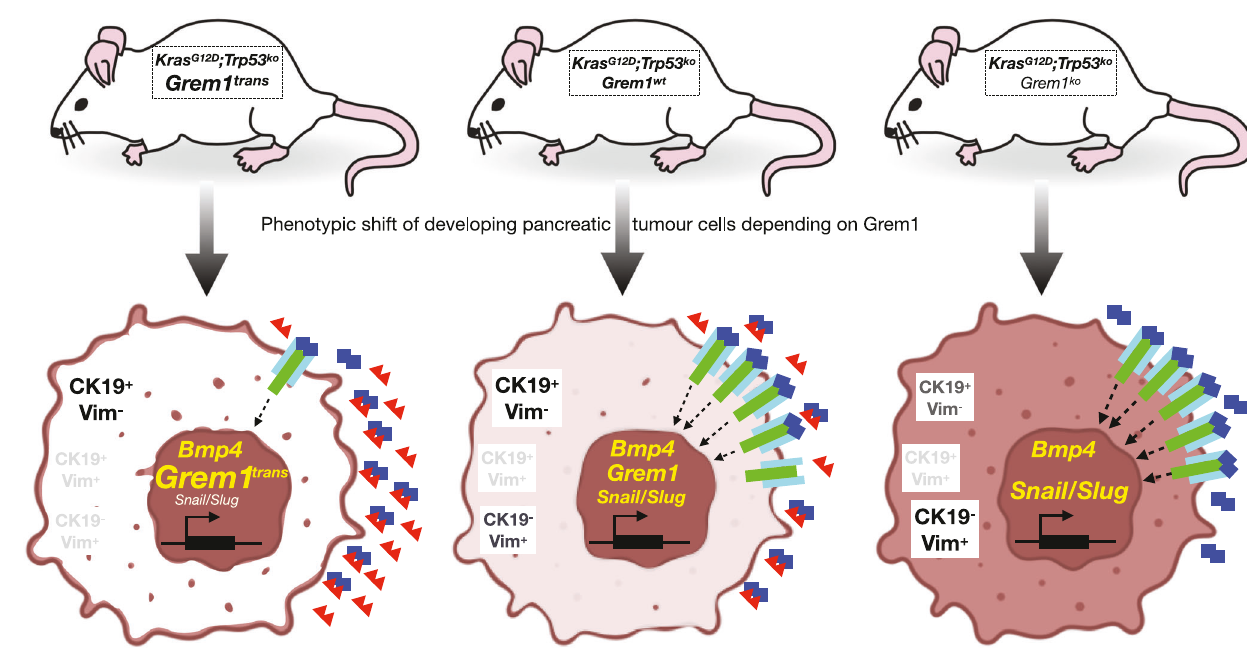
Fig. 1 Change in cellular heterogeneity according to phenotypic shift of developing pancreatic tumours ( Kras G12D ; Trp53 knockout ) depending on the presence of Grem1. The schematic cartoon highlights the shift from a predominantly epithelial, glandular tumour type containing predominantly CK19 + Vim − PDAC cells (left) to a predominantly mesenchymal, invasive pancreatic tumour type containing predominantly CK19 − Vim + PDAC cells (right) depending on the expression of Grem1 (red triangles). Bmp2 (blue squares) activating the respective Bmp receptors (light blue/green), found highly expressed in more mesenchymal (Vim + ) PDAC cells, up-regulates Grem1 expression which in turn can bind to and partially inhibit Bmp signalling via negative feedback (middle part). The phenotypic shift is indicated by gradual darkening of the schematic tumour cells (lower part). The amount of the different cellular phenotypes found in the respective tumours are indicated by letter size and -grey scale. The level of Grem1 , Snail and Slug expression are likewise indicated by size and colour code. Kras G12D , oncogenic allele of Kras with pancreas-speci fi c expression; Grem1 trans , transgenic over-expression of Grem1 ; Grem1 wt , wildtype allele of Grem1 ; Grem1 ko , pancreas-speci fi c knockout of